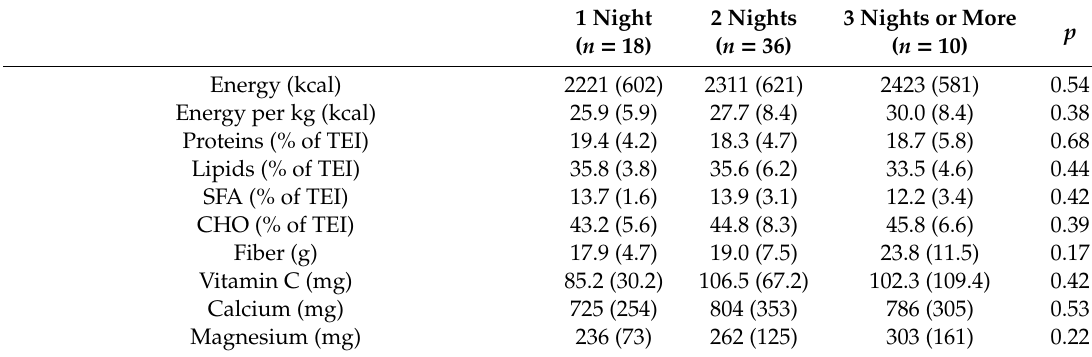
Table 2. Daily mean intakes (SD) of energy, nutrients and food groups; mean healthy score (PNNS-GS) and eating behaviors scores of shift workers working one, two, or three or more nights during the study period (5 or 6 consecutive